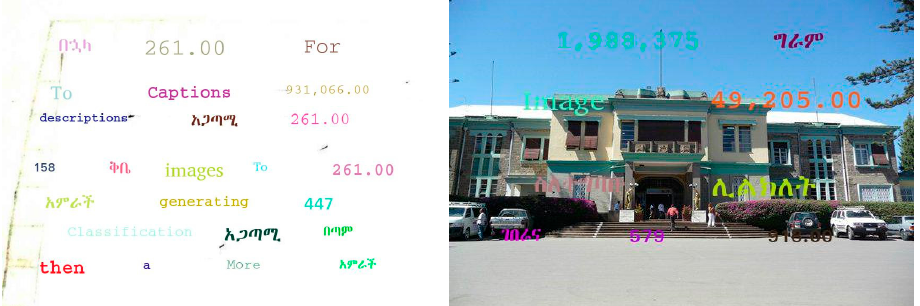
Figure 2. Sample of synthetically generated scene text images.